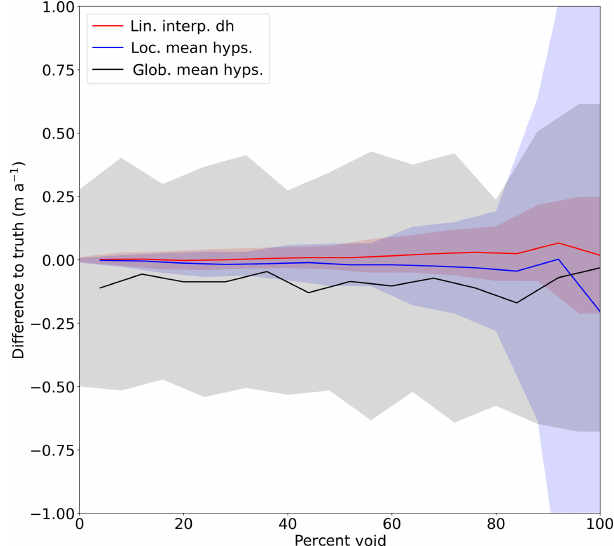
Figure 12. Difference to true mass balance as a function of void percentage for the three best-performing methods on both an indi- vidual glacier and regional basis. Shaded region around each line indicates ± standard